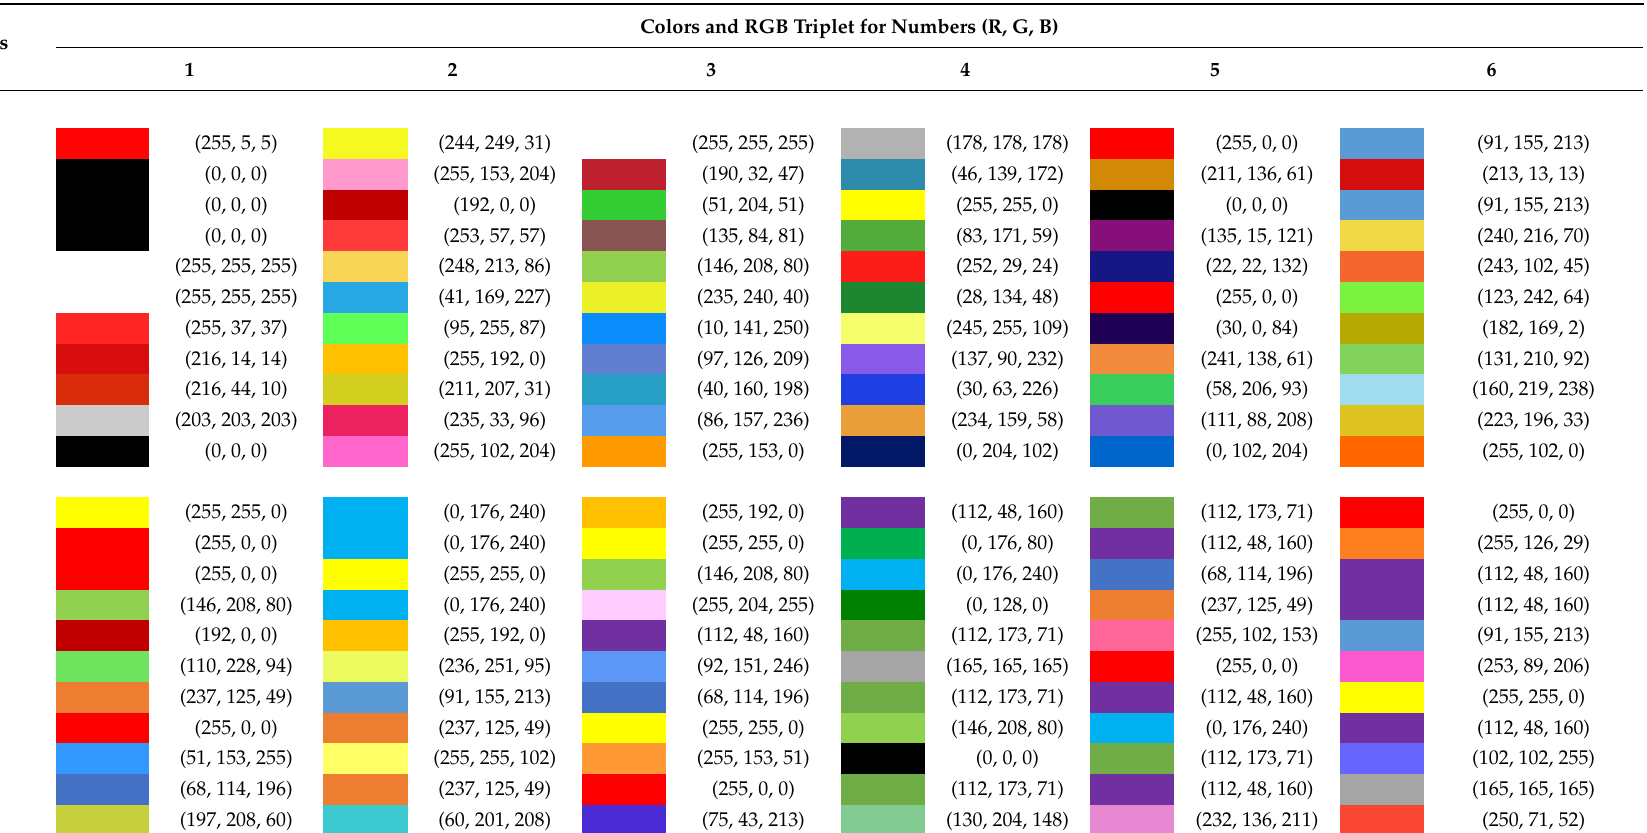
Table A1. List of numbers and colors used in the experiment for